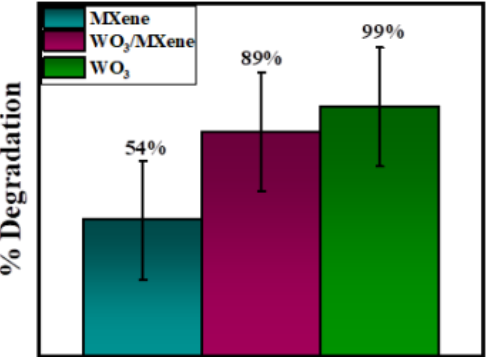
Figure 11. Comparison of degradation percentage of methylene blue using WO 3 , MXene, and WO 3 /MXene nanocomposite.